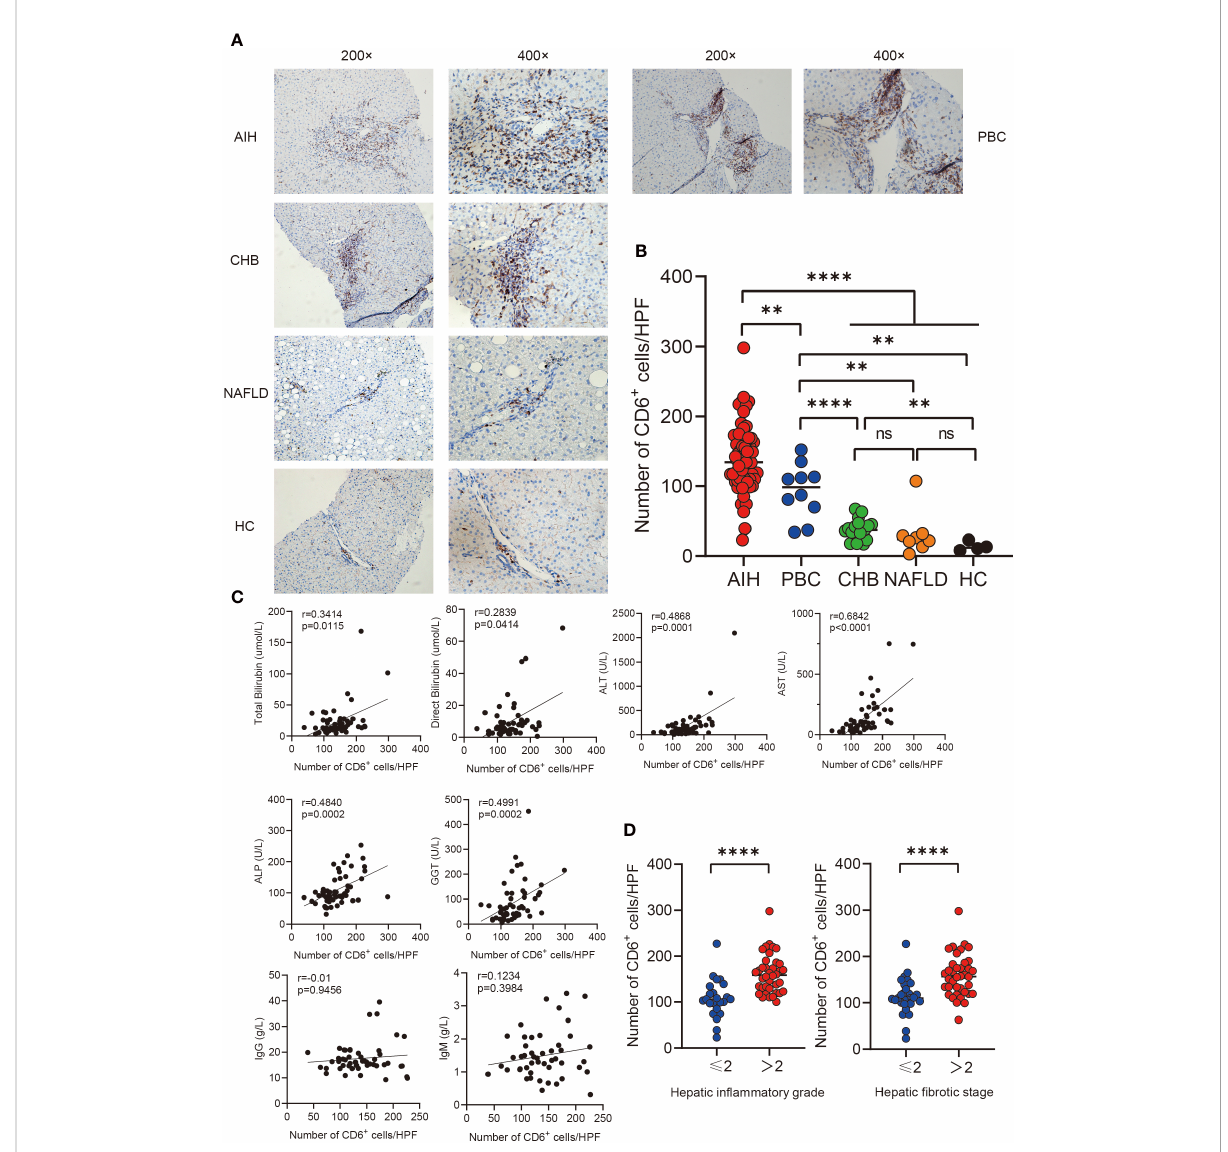
FIGURE 1 Immunohistochemistry analysis of CD6 expression in liver . (A, B) Representative immunohistochemistry images and quanti fi cation of CD6 positive cells in liver biopsies from AIH (n=61), PBC (n=10), CHB (n=17), NAFLD (n=8) and HC (n=4). (C) Correlations between the number of CD6 positive cells and clinical features of patients with AIH (n=61). (D) The number of CD6 positive cells was compared between different in fl ammatory grades and fi brosis stages. **p < 0.01, ****p < 0.0001, ns: not signi fi